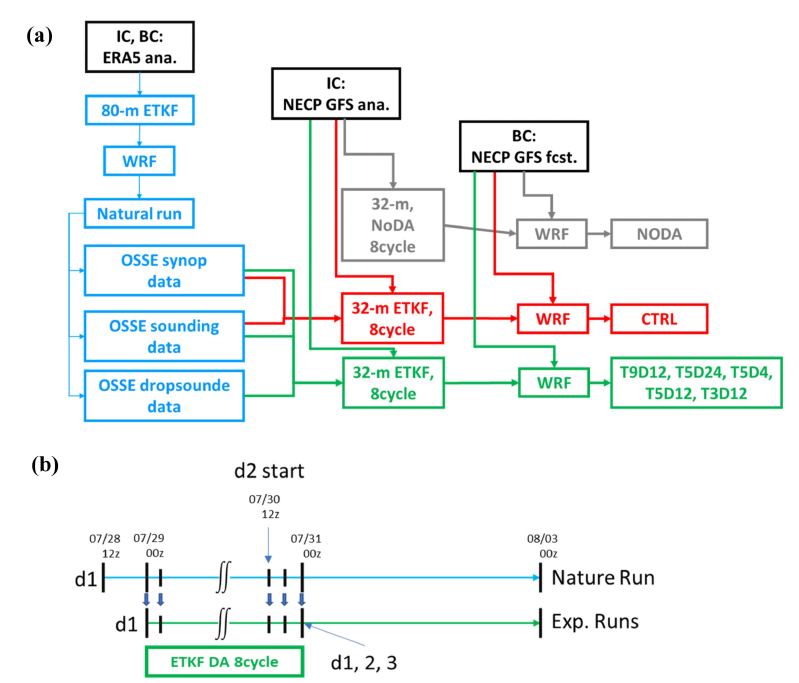
Figure 2. ( a ) The flowchart of the NR and the experimental runs, including NODA, CTRL, T5D12, T9D12, T3D12, T5D24, and T5D4. ( b ) Time frames of the NR (cyan) and the experimental runs (green).